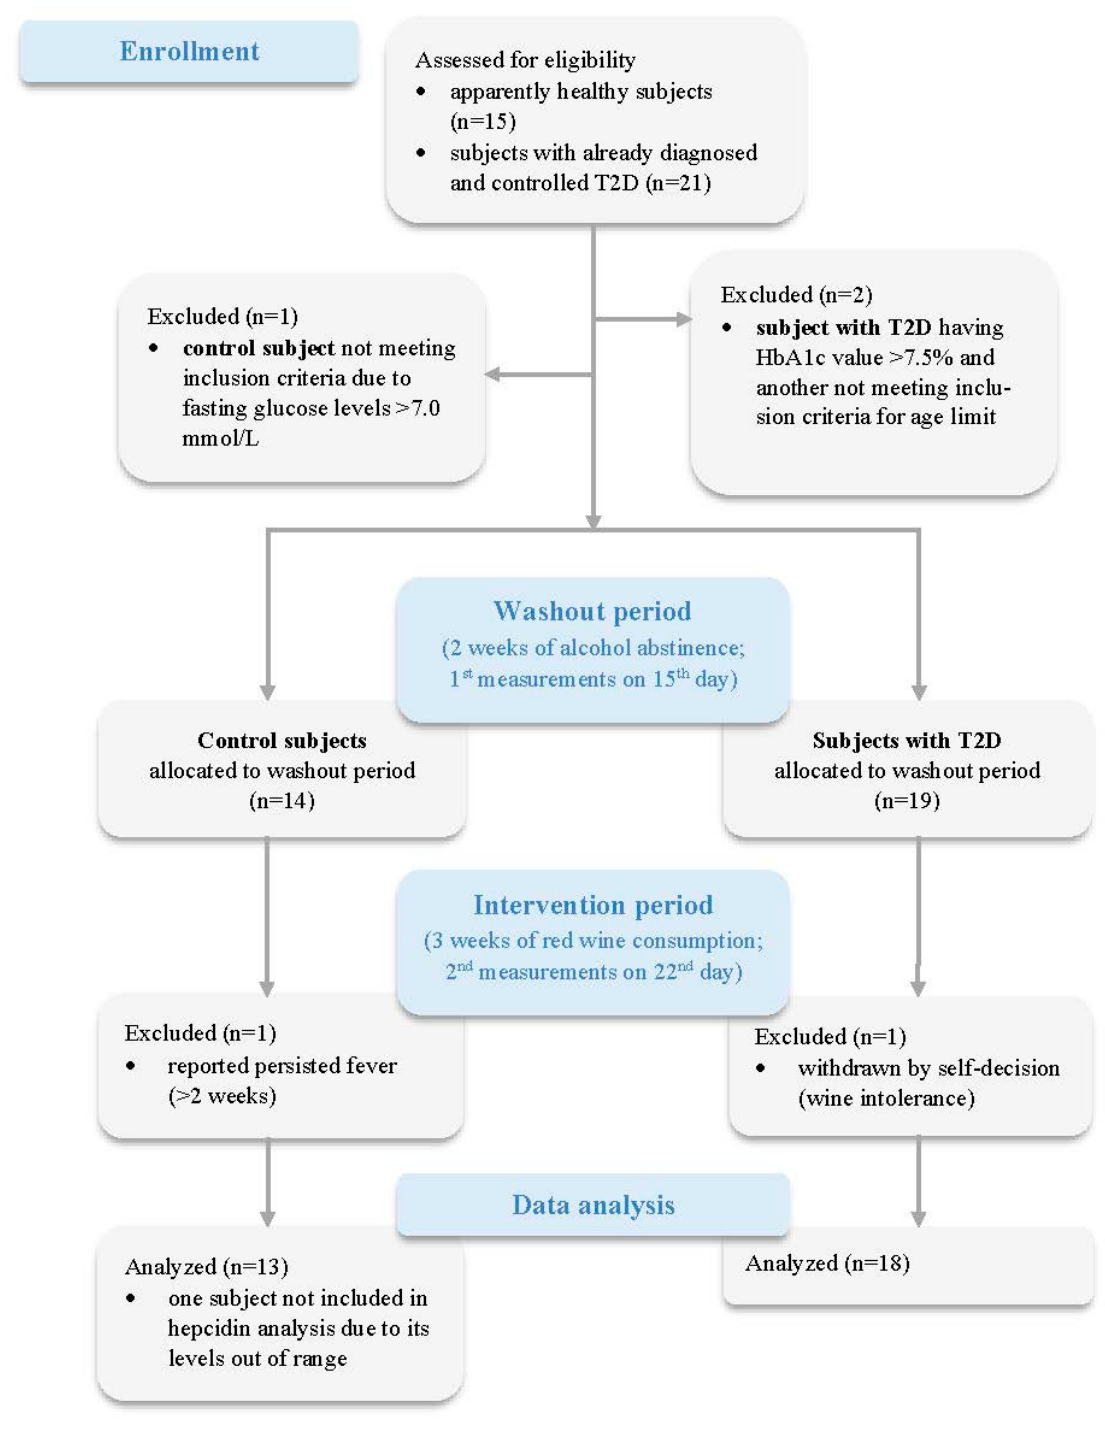
Figure 1. CONSORT flow diagram showing the recruitment processes and study protocol.